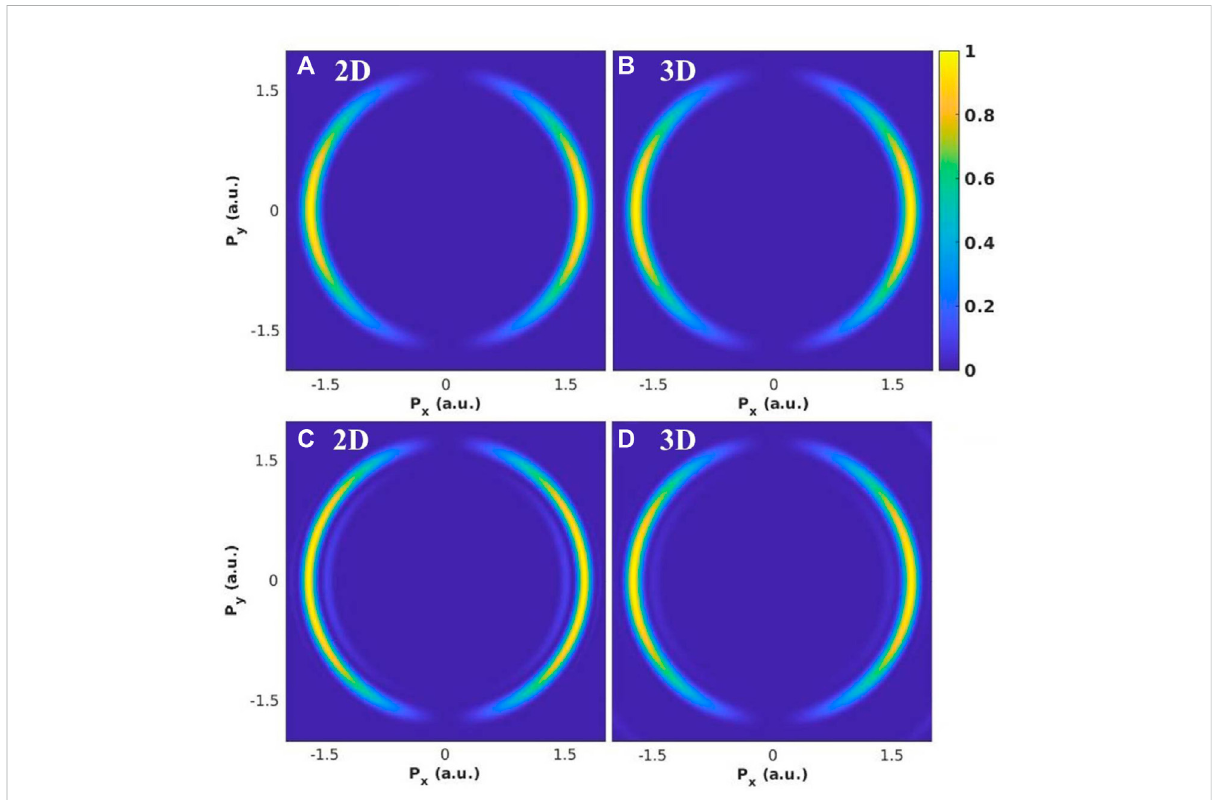
FIGURE 1 (Color online) Numerical results are compared from solving two- and three-dimensional TDSEs. We take thelaser parametersas follow:carrier frequency Z ω 0 = 53.605 eV and peak intensities are (A,B) I 0 = 10 12 W/cm 2 , and (C,D) I 0 = 10 18 W/cm 2 , corresponding to the perturbation regime and the stabilization regime. Laser pulse duration τ = 1.5